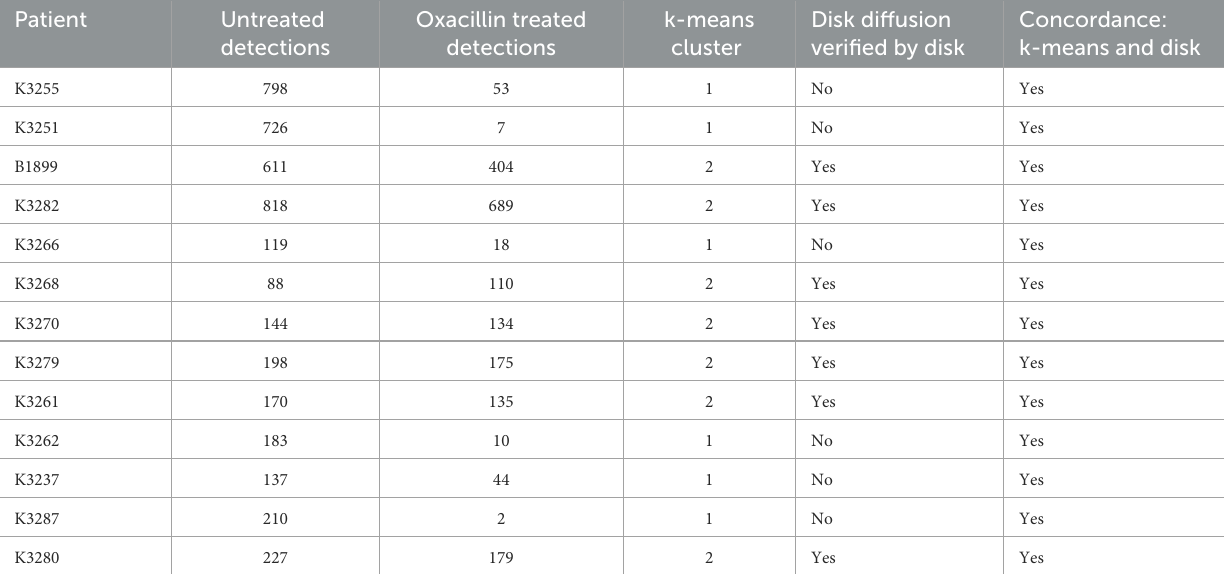
TABLE 1 Comparison of treated and untreated photoacoustic detections of S. aureus . Patient Untreated Oxacillin treated k-means Disk diffusion Concordance: detections detections cluster verified by disk k-means and